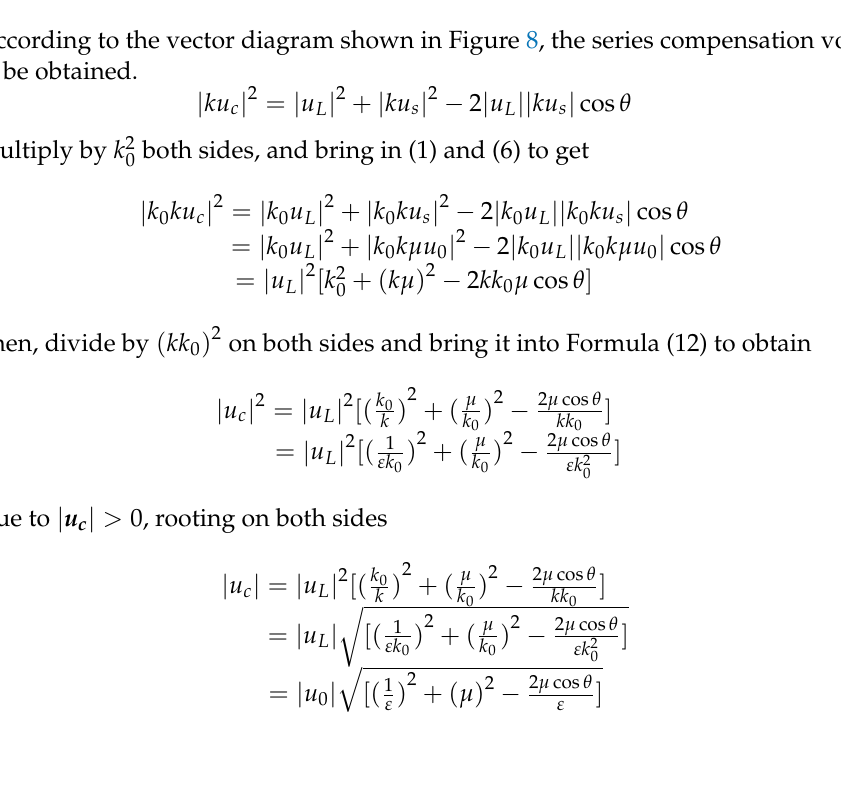
Figure 9. Schematic diagram of composite control vector at secondary side.